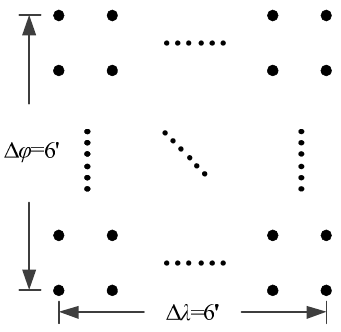
Figure 7. The subdivision of 6 ′ × 6 ′ .